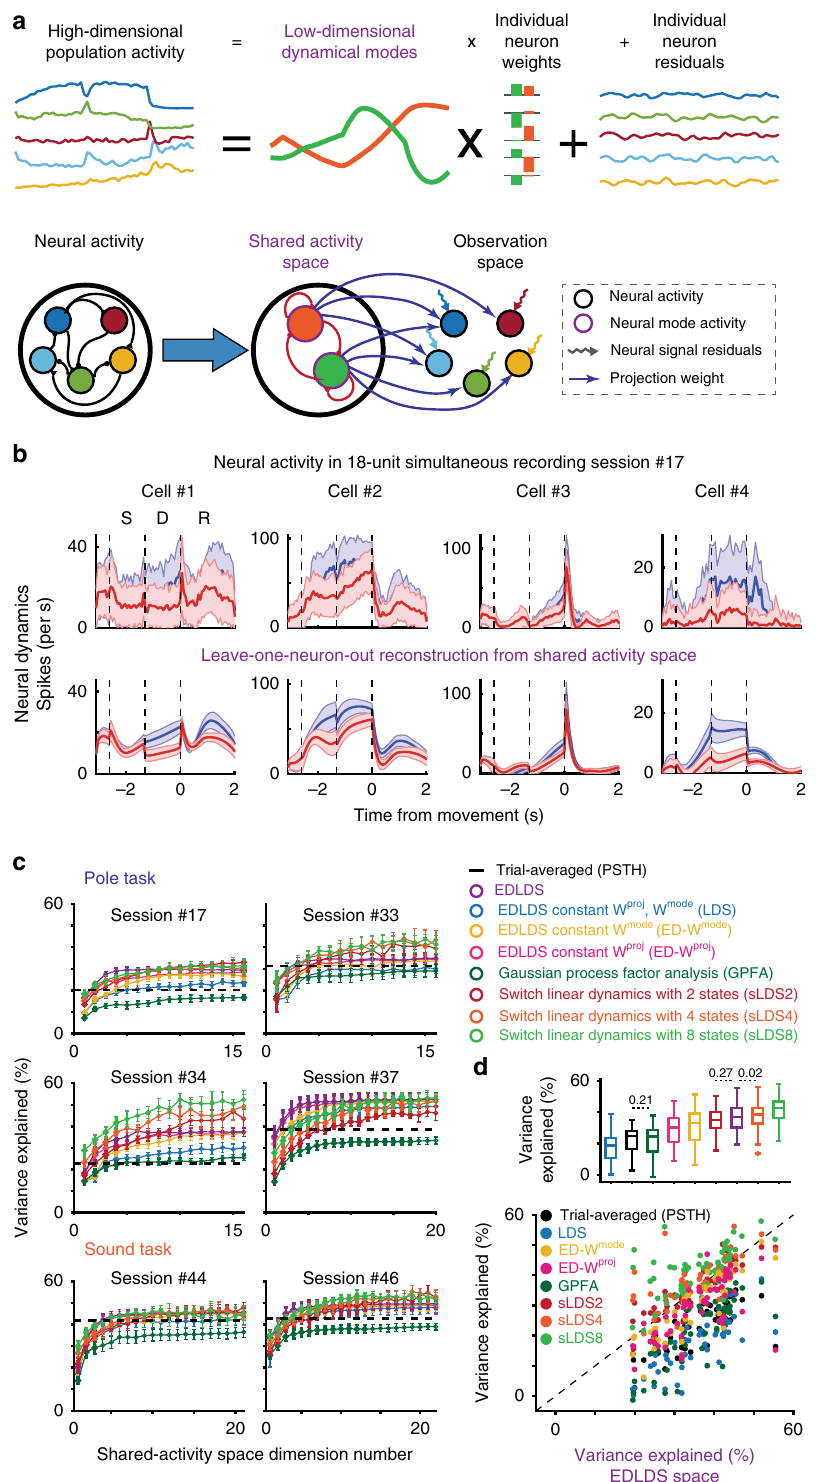
(sLDS2)Gaussian process factor analysis (GPFA) Switch linear dynamics with 2 states Switch linear dynamics with 4 states (sLDS4) Switch linear dynamics with 8 states